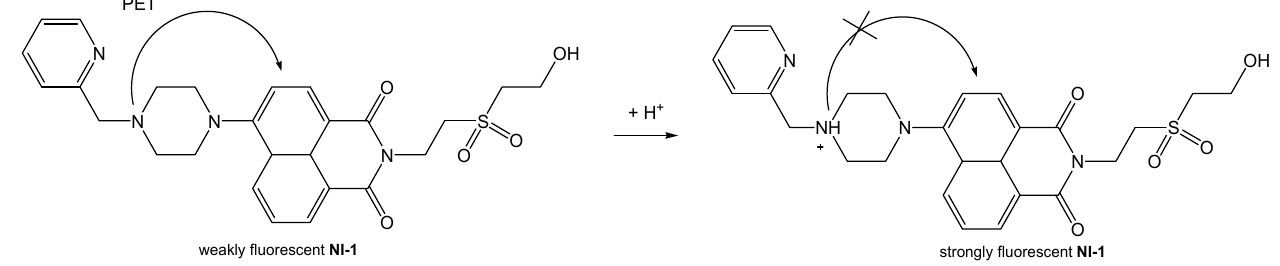
Figure 4. Schematic representation of PET process using NI-1 as an example.